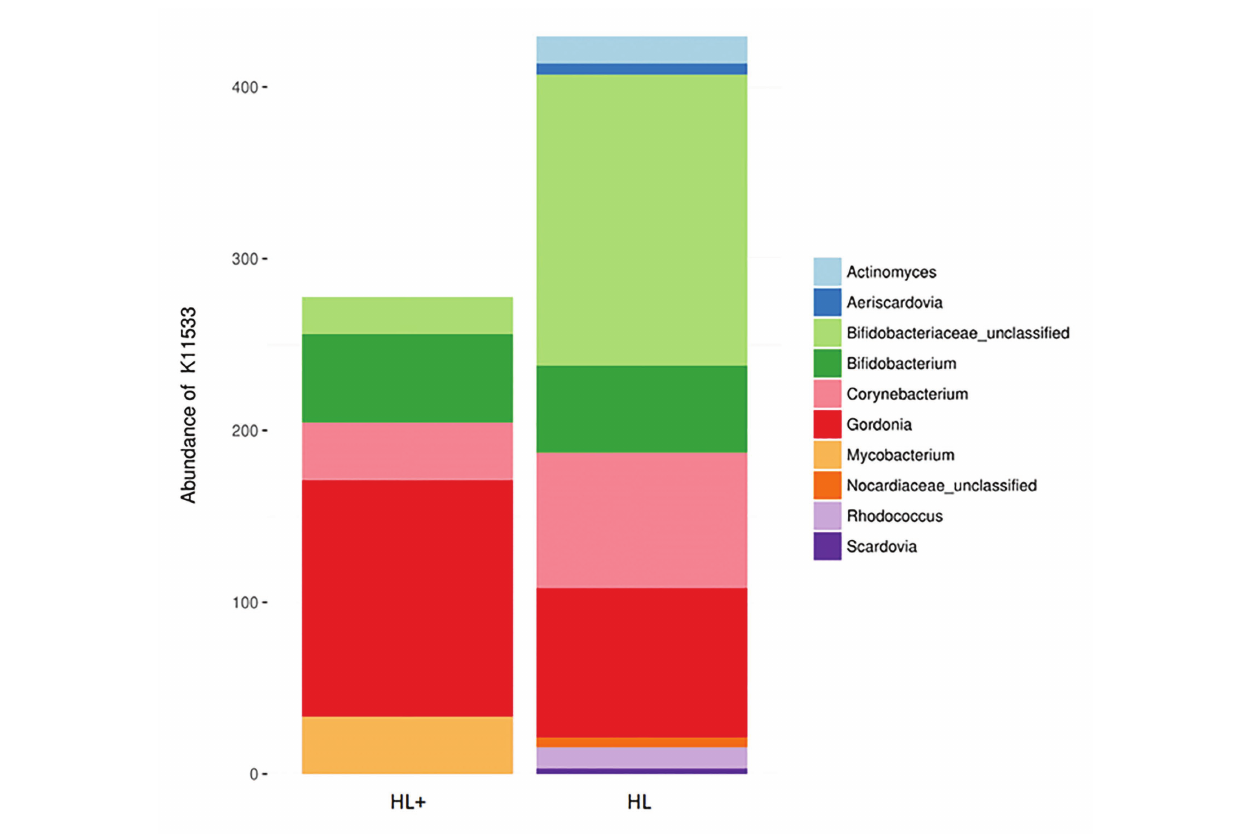
FIGURE 7 | Contribution of bacterial OTUs to the abundance of KEGG ortholog K11533 (fatty acid synthase – see Figure 6C ) in the gut of Atlantic salmon ( N = 72) fed high lipid with additional n-3 LC-PUFA (HL+) or